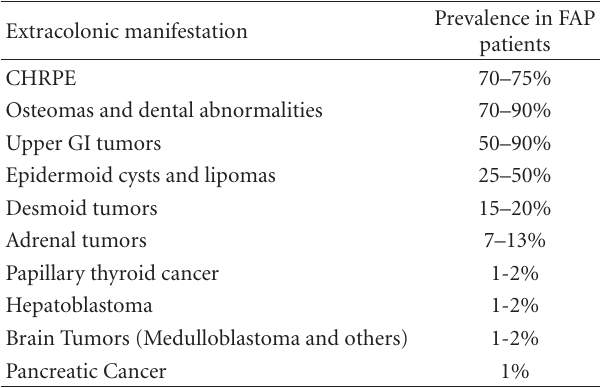
Table 2: Extracolonic FAP manifestation (Neiuwenhuis [33] and Groen